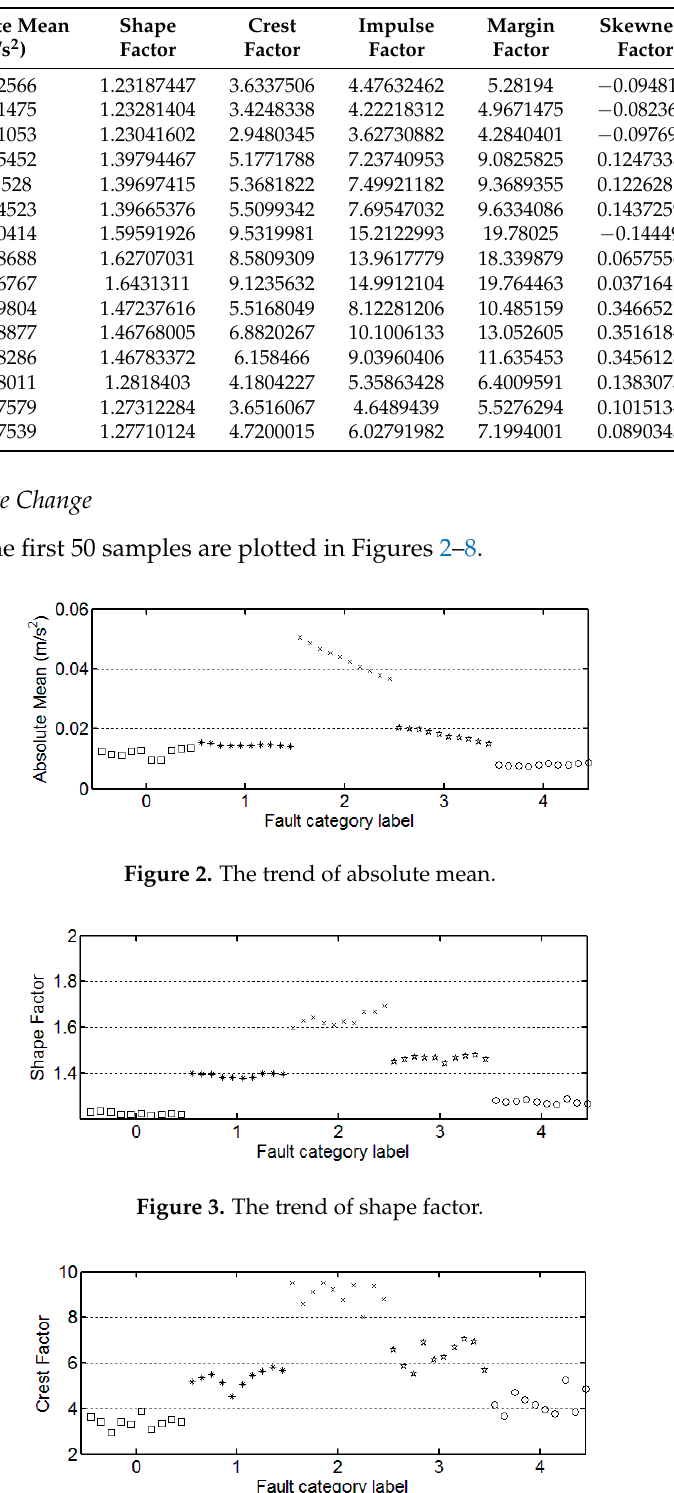
Table 3. Value of statistical features.